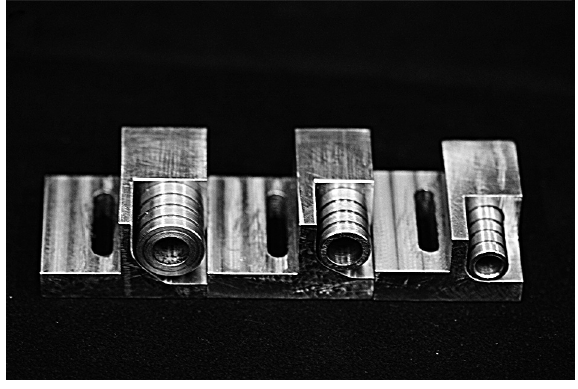
Figure 2. A photo of the apparatus in cross-section.